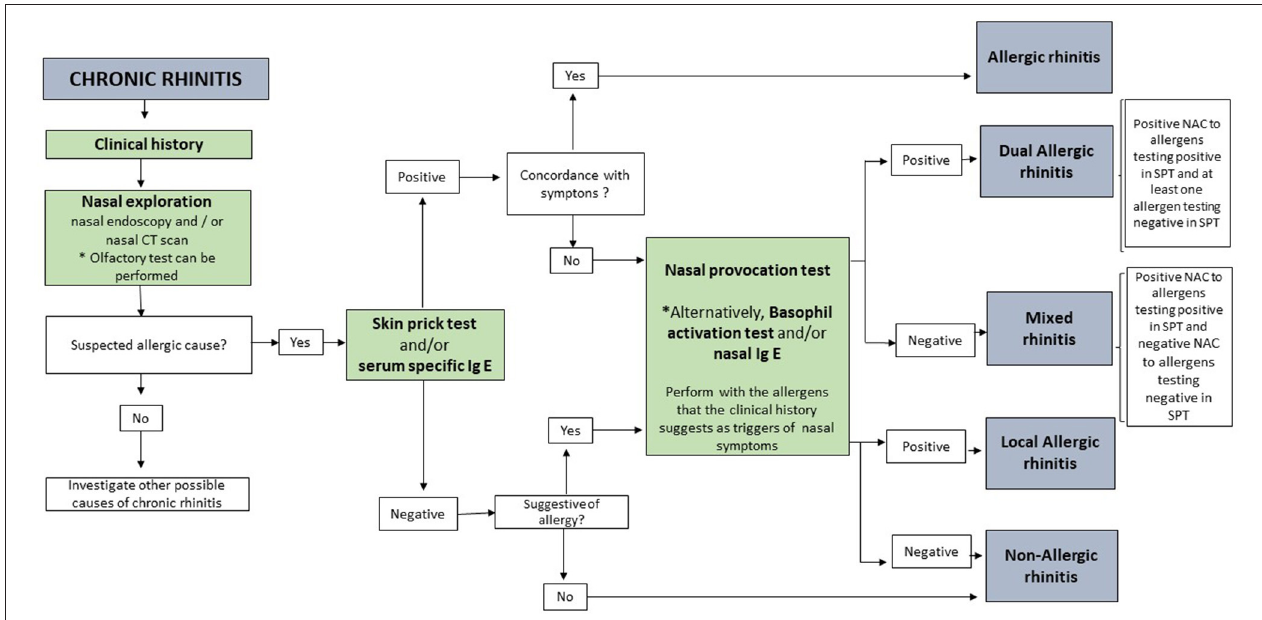
FIGURE 2 | Diagnostic algorithm for chronic